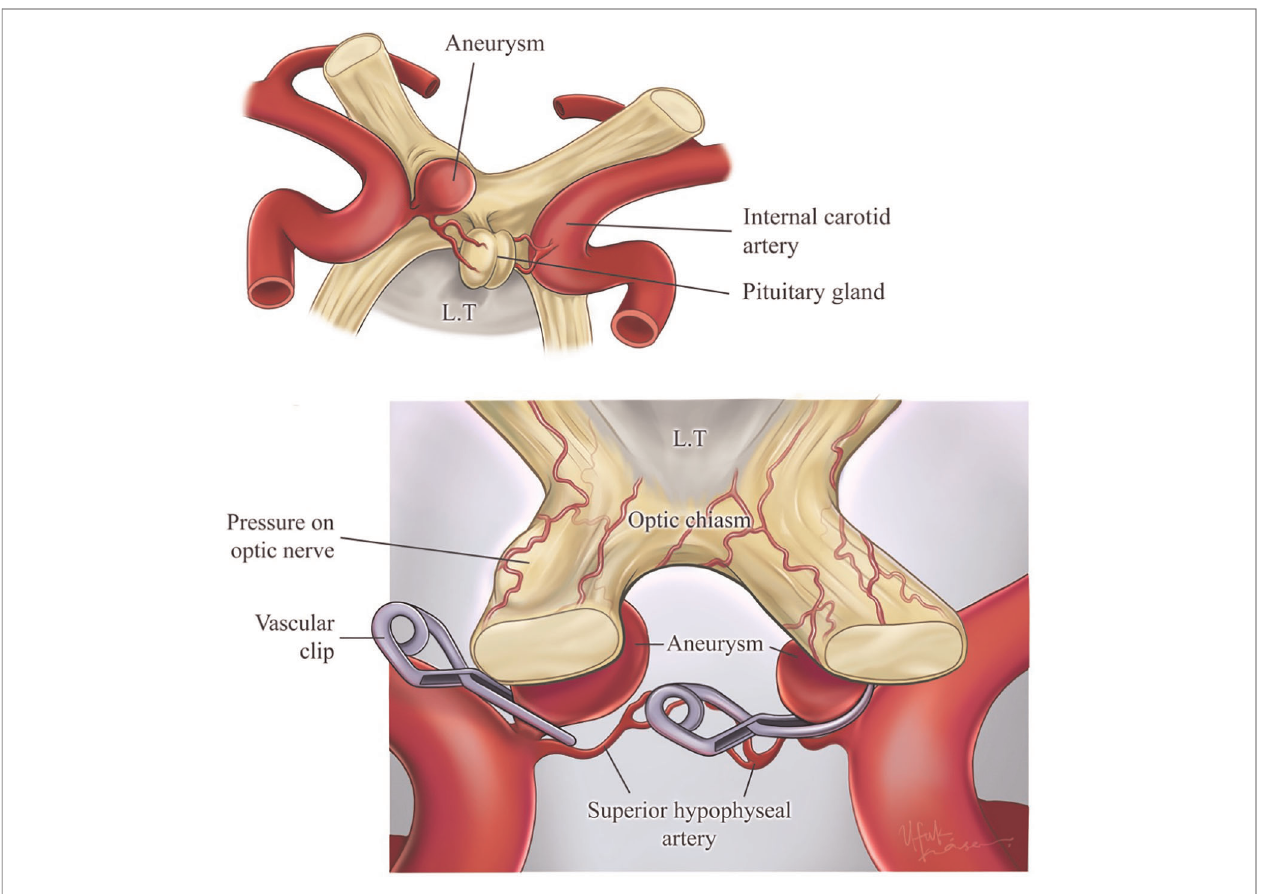
FIGURE 6 | Illustration of superior hypophyseal artery aneurysms, contralateral – ipsilateral aneurysm clipping. The right superior hypophyseal artery has aneurysms that are not suitable for the contralateral approach because of the aneurysm size and the challenge of reaching the aneurysm dome. Also, this aneurysm ’ s pressure on the optic nerve has been illustrated. This aneurysm is suitable for the ipsilateral approach. On the other hand, the illustrated left superior hypophyseal artery aneurysm is suitable for the contralateral approach because of the aneurysm size (small). Also, this aneurysm allows reaching the aneurysm dome by the contralateral approach. Printed with permission from Ufuk